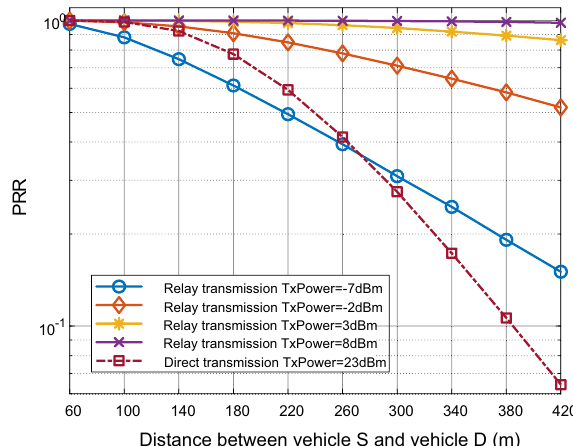
Fig. 13 PRR performance without interference